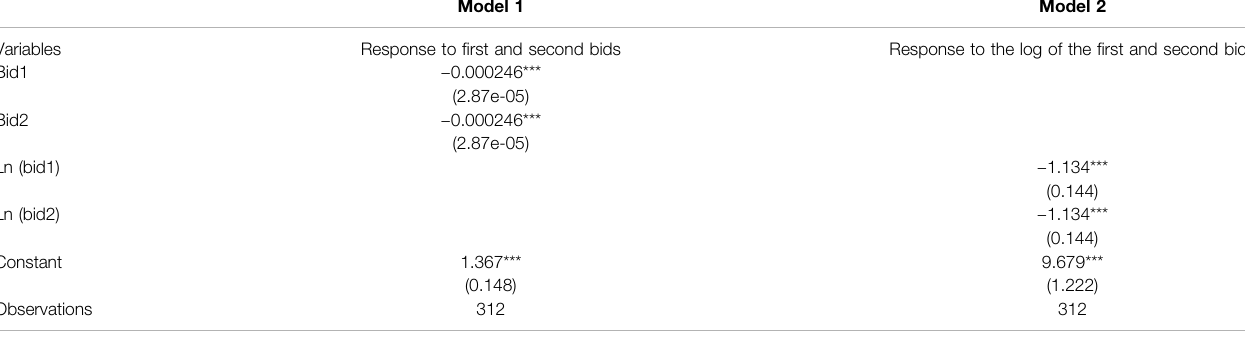
TABLE 3 | Estimations of models 1 and 2